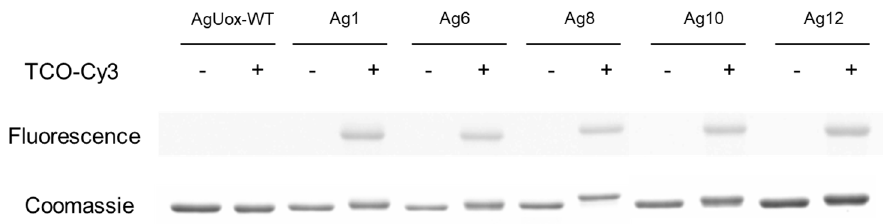
Figure 4. Incorporation of frTet into AgUox. Fluorescence (illumination λ ex = 302 nm, with wave- lengths at 510 and 610 nm in Chemidoc XRS+ system) and Coomassie blue-stained protein gel for reaction mixture of TCO-Cy3 with AgUox-WT or AgUox-frTet (Ag) variants.